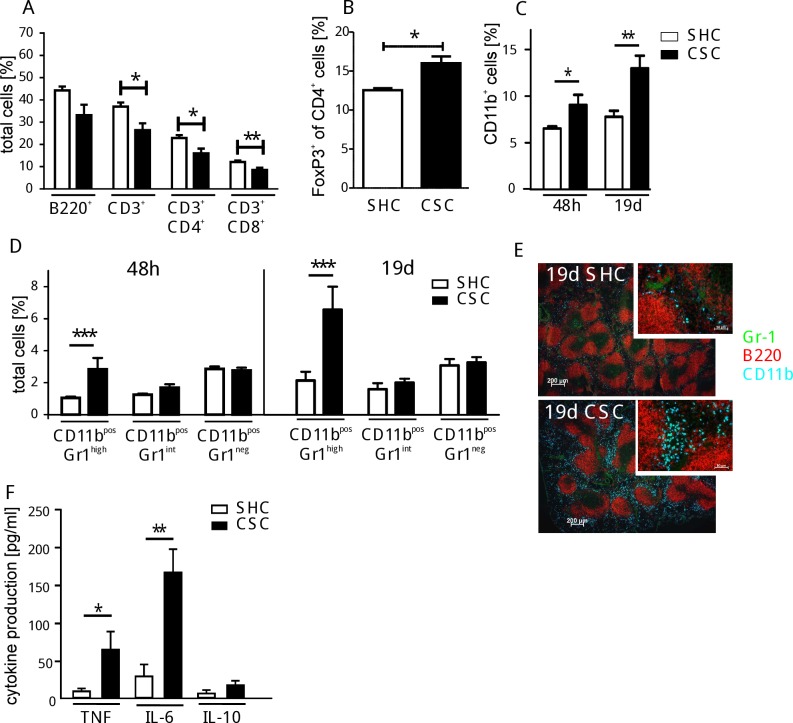
Effect of CSC on spleen cells.Splenocytes from CSC (black bars) and SHC mice (white bars) were isolated and analyzed by flow cytometry (total splenocytes SHC, n = 7: 4.2±1.7x107; CSC, n = 8: 9.8±2.4x107). The percentage of splenic B (SHC: 1.9±0.8x107; CSC: 3.2±0.8x107) and T cells (SHC: 1.6±0.3x107; CSC: 2.6±0.6x107) (A) and Treg cells (SHC: 2.0±0.4x106; CSC: 2.6±0.6x106) (B) were quantified after 19d of SHC/CSC. Splenic CD11b+ cells (C) and CD11b+ cells differentiated by their Gr1 expression level were analyzed after 48h and 19d of CSC (SHC: n = 8, CSC: n = 8) (D). Immunohistochemical staining of spleen sections from mice after 19d of CSC/SHC for CD11b+ (blue), Gr1+ (green), and B220+ (red) cells was performed (E). Splenocytes from individual mice after 19d CSC/SHC were stimulated with LPS followed by determination of TNF, IL-6, and IL-10 levels in the supernatants (SHC: n = 4, CSC: n = 4) (F). *p < 0.05; **p < 0.01; ***p < 0.001 (Student´s t-test). These experiments were performed at least 3 times.